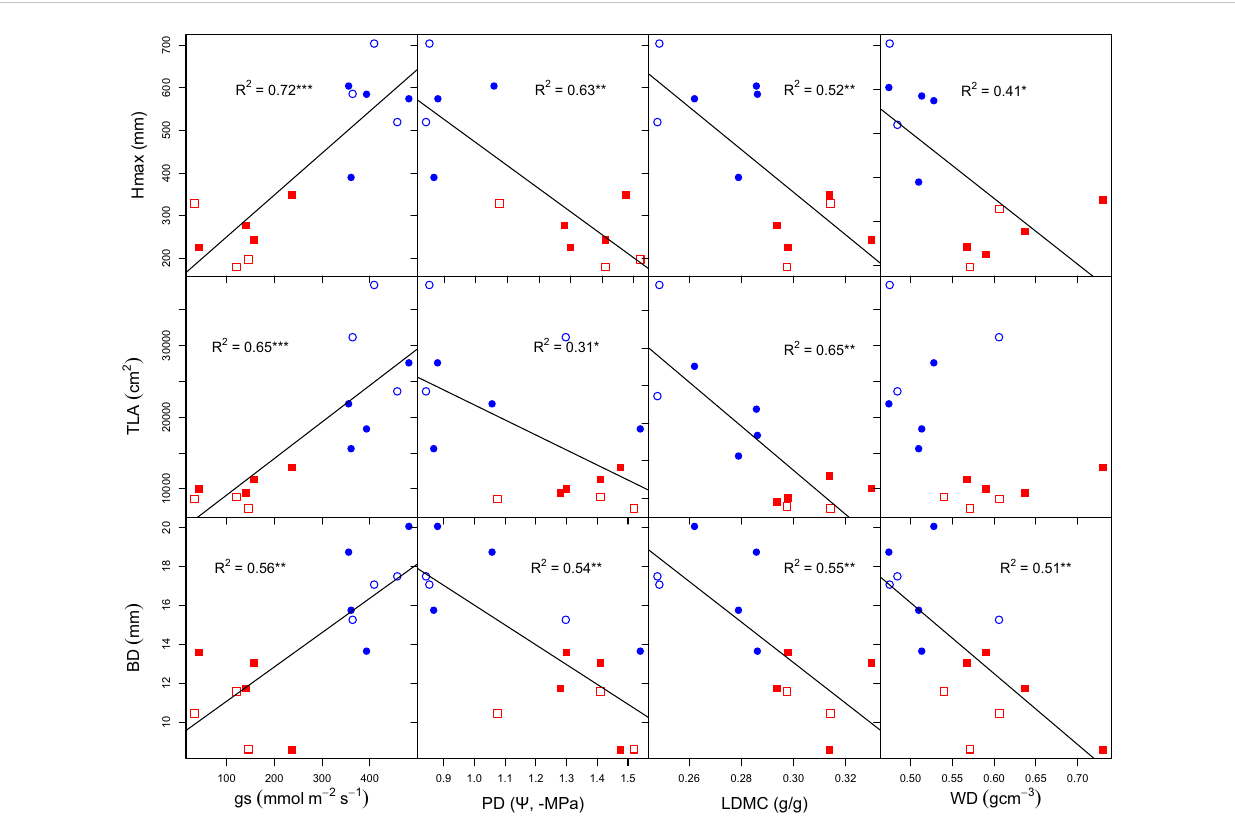
FIGURE 3 Bivariate relationships of growth, morphological and physiological traits. Hmax, maximum plant height; gs, stomatal conductance; WD, wood density; PD, predawn water potential; TLA, total leaf area; TLA, total leaf area; BD, basal diameter and LDMC, leaf dry matter content. Open and closed shape signi fi es dry and wet climate-origin, while blue-circle and red-square signi fi es water-limited and well-watered treatments. R2 adjusted R-squared. Signi fi cant codes: 0 ‘ *** ’ 0.001 ‘ ** ’ 0.01 ‘ * ’